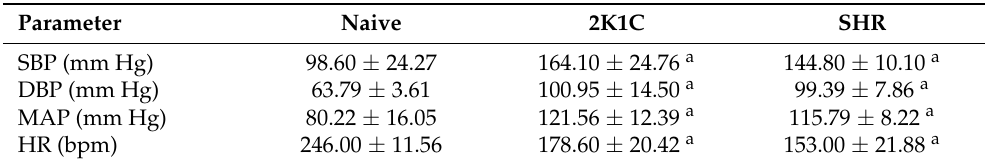
Table 3. Blood pressure and heart rates of the different experimental groups at the end of 6 weeks of treatment with the high-fat diet.